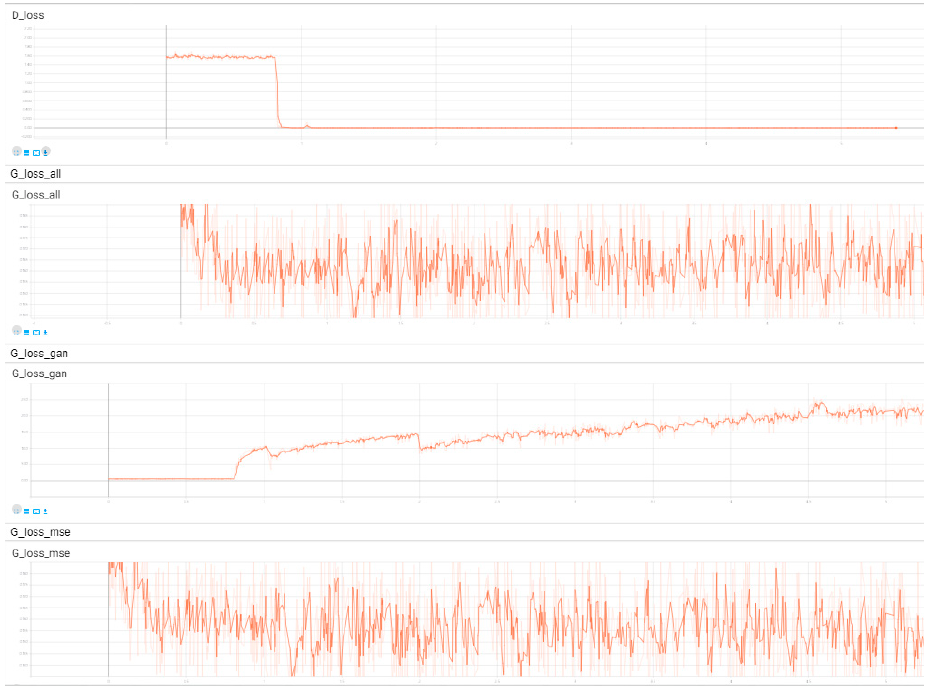
Figure 7. The losses graph of the Iizuka’s network structure.